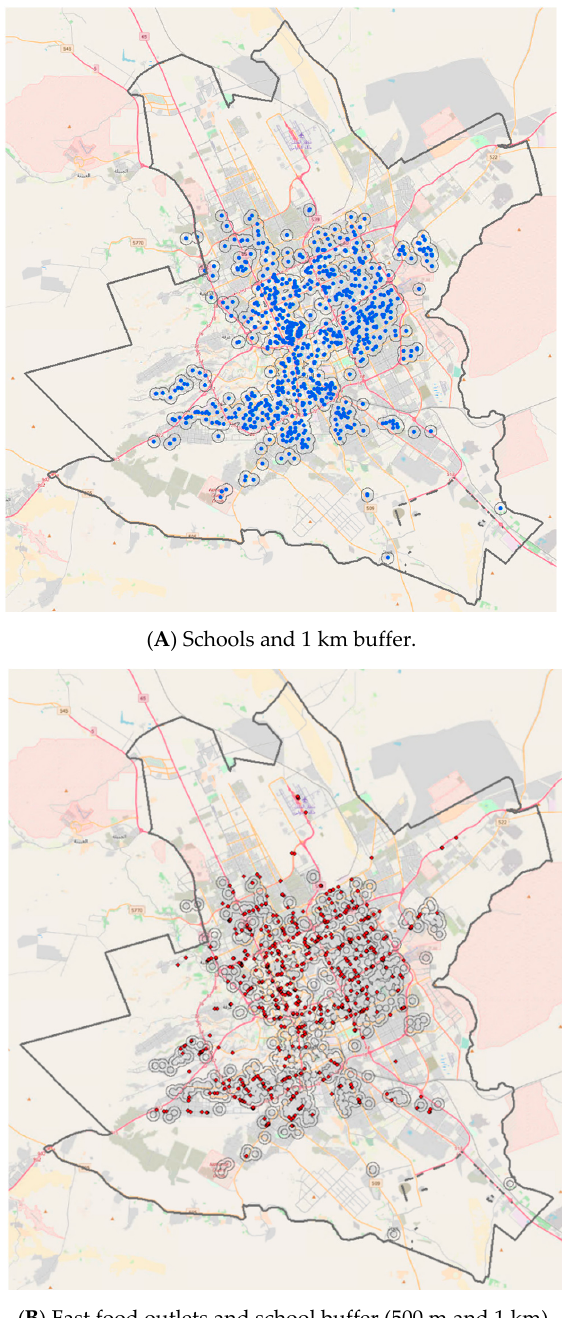
Figure 1. Visibility of fast food outlets around schools in Riyadh city. Note: In panel ( A ), blue dots show schools and grey lines show 1 km dissolved buffers around schools. In panel ( B ), red dots show fast food outlets and grey lines show 500 m and 1 km buffers around schools.